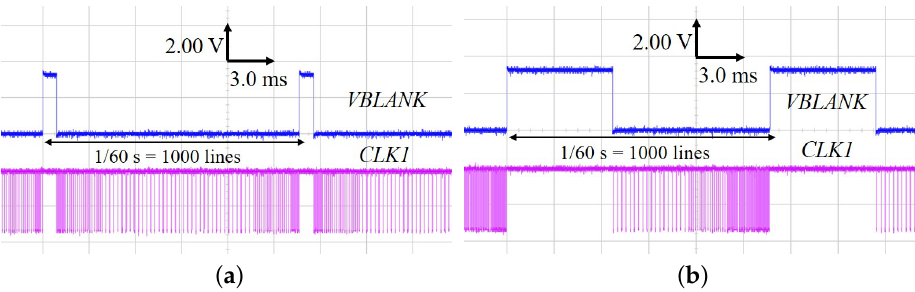
Figure 12. Fixed frame time of 1000 lines by variable vertical blanks: ( a ) foveation point is located at the center with the active region of 950 and the vertical blank of 50; and ( b ) foveation point is located at the uppermost with the active region of 602 and the vertical blank of 398.